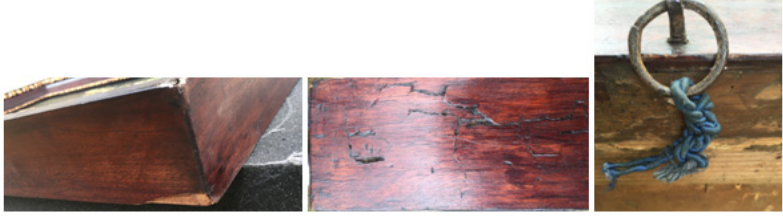
Figure 14. Fixing ring of the painting.